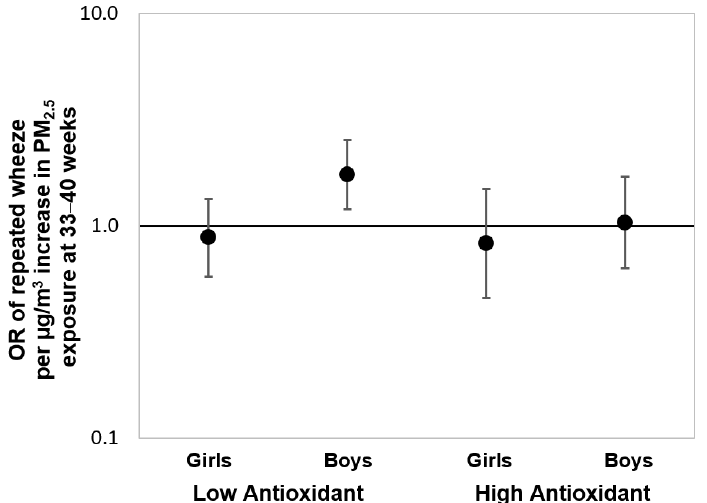
Figure 4. Odds ratios (95% CIs) of child’s repeated wheeze corresponding to PM 2.5 exposure at 33–40 weeks gestation in Black mothers, stratified by antioxidant intake and child sex. Results from multivariable-adjusted logistic regressions examining the associations between prenatal PM 2.5 exposure level averaged over 33–40 weeks gestation (i.e., the sensitive exposure window identified by BDLIM) and offspring’s repeated wheeze among Black mothers, stratified by antioxidant intake status (high vs. low intake categorized by median split) and child sex. The models were adjusted for maternal age at delivery, maternal education, maternal history of asthma, and prenatal averaged